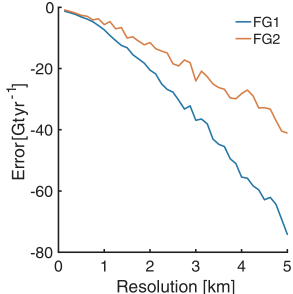
Figure 5. Error in total Antarctic discharge (relative to best esti- mate) when velocity and ice thickness are averaged for increasing along-flux-gate resolutions prior to computing